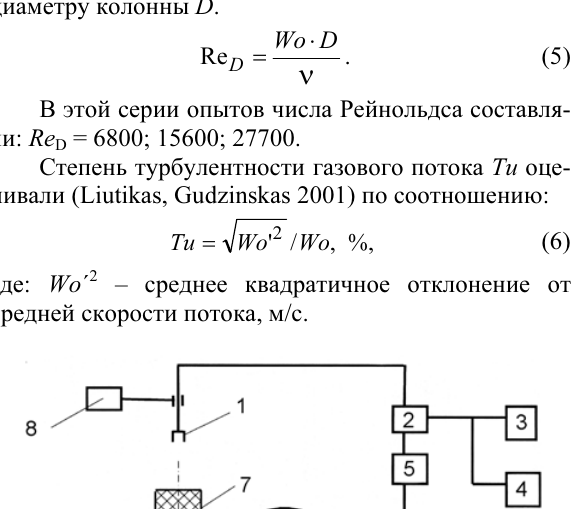
Fig 6. Dependence of loss of pressure ∆ P/Н on linear air velocity Wo for dry ceramic sedimentation from high po- rosity material: ● – the first test; x – repeated measure- ment of pressure loss after a series of tests of mass transfer